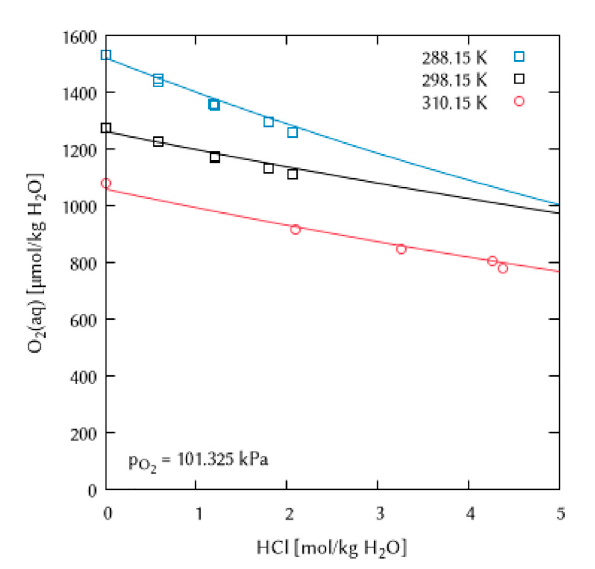
FIGURE 12 Modelling of the O 2 solubility in sodium hydroxide solution as a function of temperature and NaOH concentration. (Points: Experimentaldata from □ Geffcken (1904), n Chatenet etal. (2000), ▽ Lang and Zander (1986) and ⬦ Bruhn et al. (1965), Lines: this